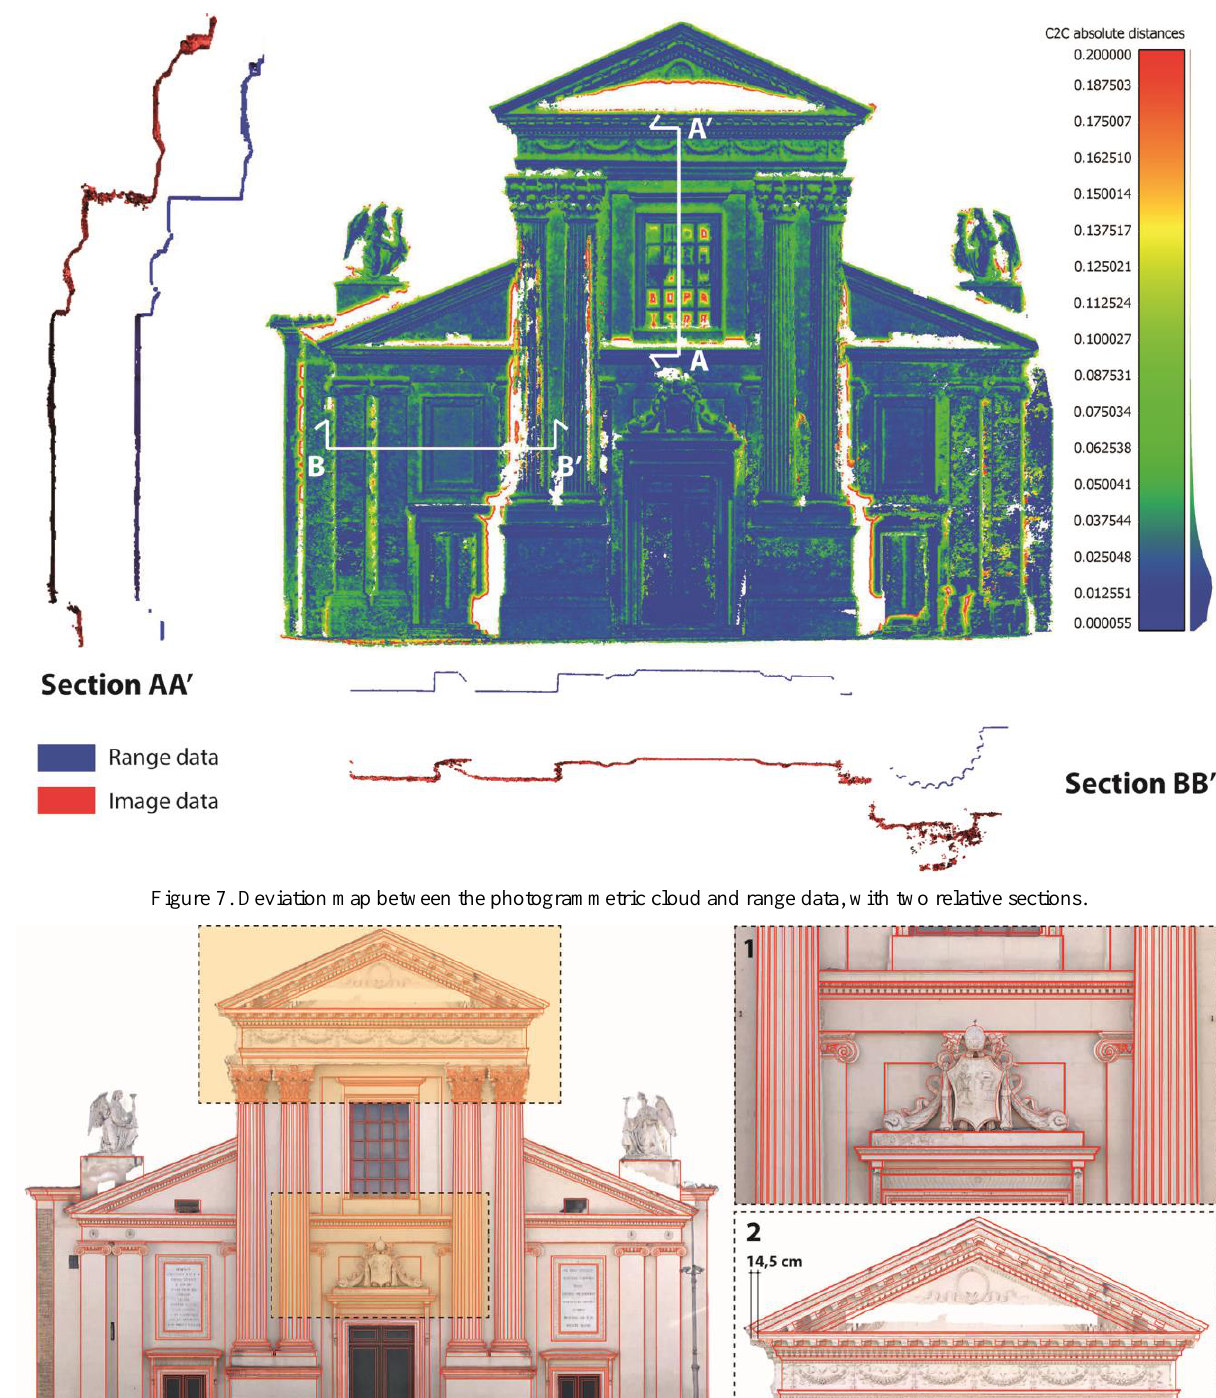
Figure 8. Overlapping of the façade drawing with the orthophoto, with close-up on two specific